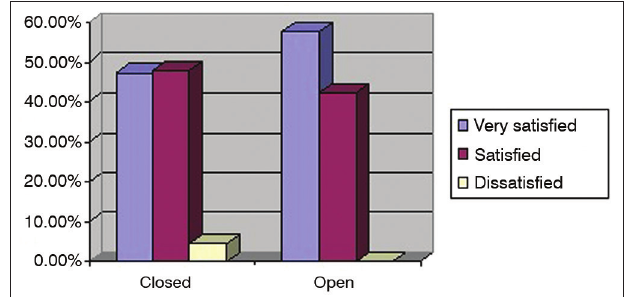
Figure 6. Percent distribution of hearing aid fitting type per level of global